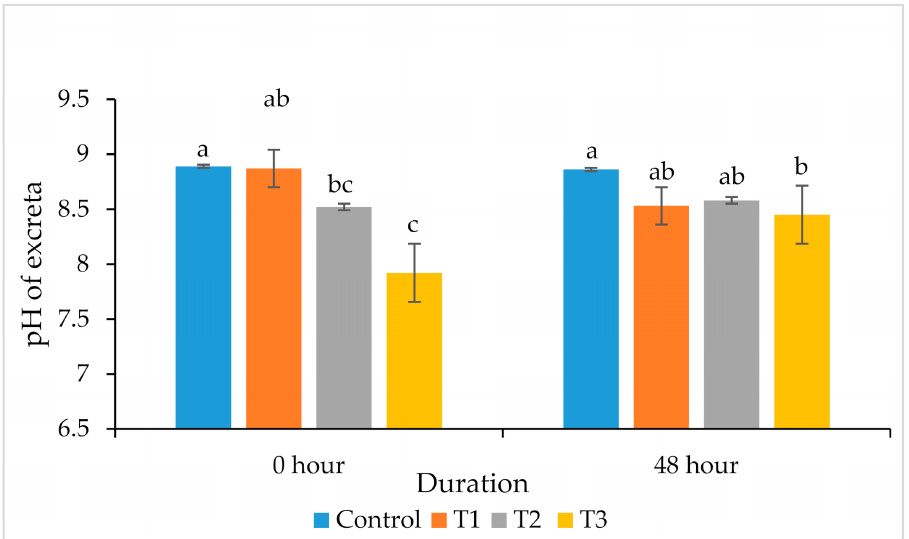
Figure 3. Effects of Mentha arvensis (MA) and Geranium thunbergii (GT) on the pH of excreta. a,b,c Bars within a particular point not sharing a common letter differ significantly ( p < 0.05). n = Each value represents the mean of 6 replications with 4 birds per